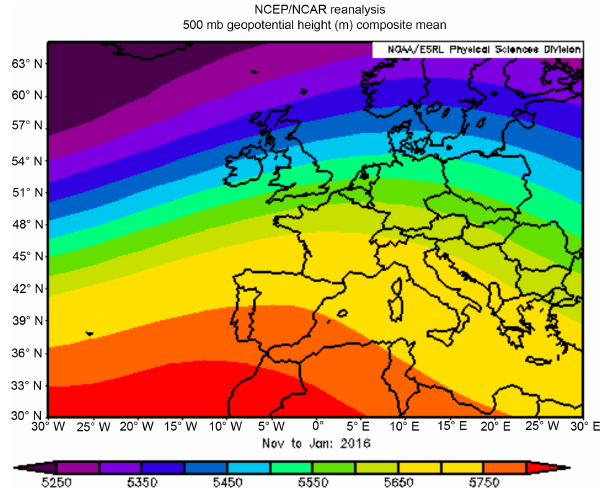
Figure 12. Mean geopotential height at 500hPa for November 2015–January 2016 (source NCEP/NOAA reanalysis).